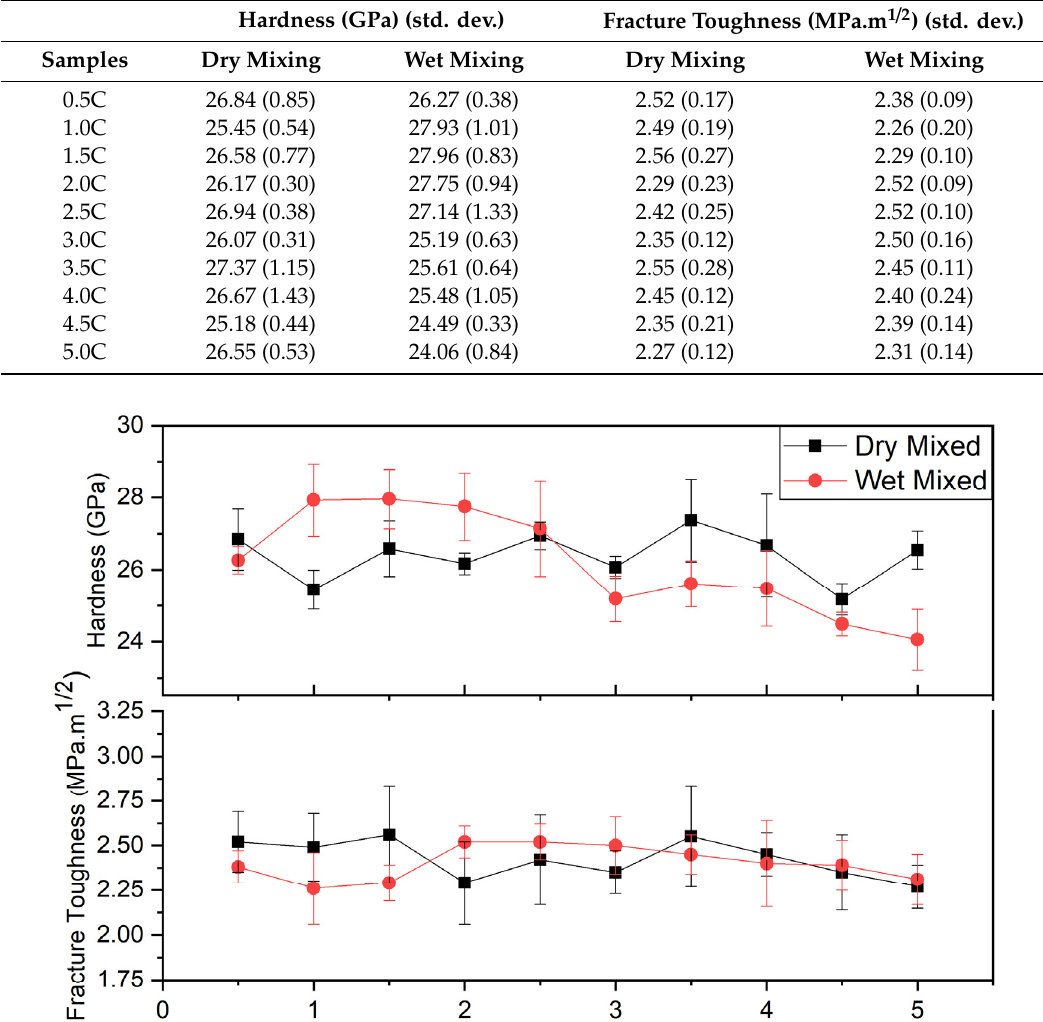
/ 2 . Silicon carbide has a